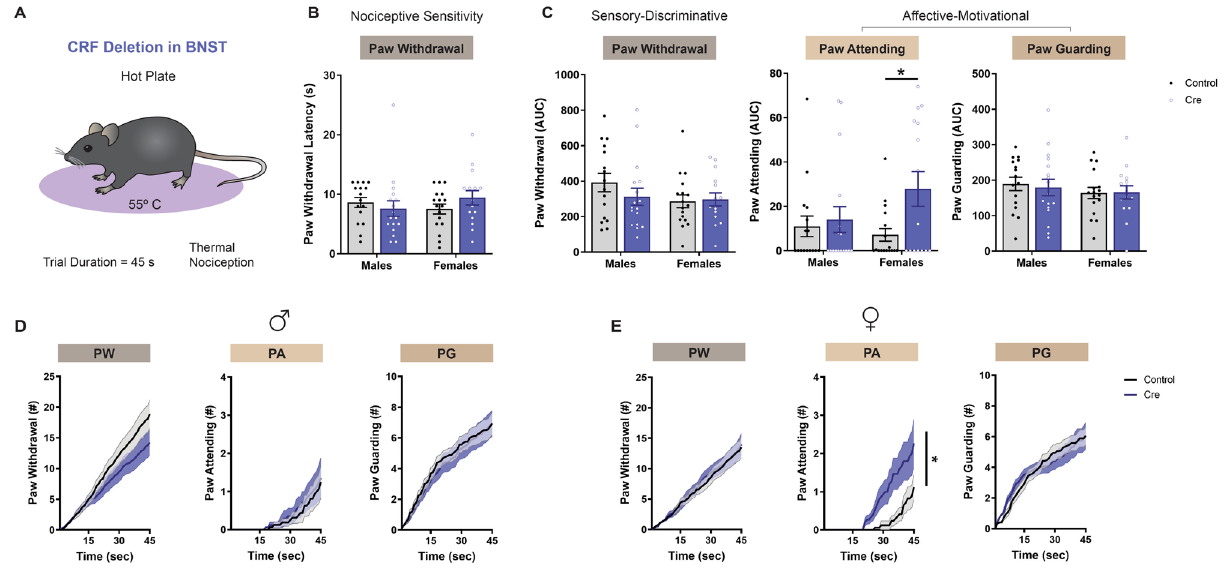
Figure 6. CRF Deletion in BNST Selectively Alters Sensory-Discriminative and Affective-Motivational Behaviors. ( A ) Schematic of hot plate test. ( B ) Thermal nociceptive sensitivity of male (n = 16–17) and female (n = 15–17) Floxed-CRF mice, as defined by latency to first paw withdrawal for each mouse (Two- way ANOVA with Tukey’s post hoc: no Sex × Virus interaction [F(1, 61) = 1.853, P = 0.1785] or main effect of Sex [F(1, 61) = 0.1124, P = 0.7386] and Virus [F(1, 61) = 0.1524, P = 0.6976]). ( C ) Quantification of sensory- discriminative and affective-motivational behaviors throughout the 45-s exposure to hot plate. Averaged area under the curve (AUC) of paw withdrawal (Two-way ANOVA with Tukey’s post hoc: no Sex × Virus interaction [F(1, 61) = 1.072, P = 0.3047] or main effect of Sex [F(1, 61) = 1.885, P = 0.1747] and Virus [F(1, 61) = 0.6208, P = 0.4338]), paw attending (Two-way ANOVA with Tukey’s post hoc: no Sex × Virus interaction [F(1, 61) = 2.605, P = 0.1117] or main effect of Sex [F(1, 61) = 0.8298, P = 0.3659]; main effect of Virus [F(1, 61) = 4.695, P = 0.0342]), and paw guarding (Two-way ANOVA with Tukey’s post hoc: no Sex × Virus interaction [F(1, 61) = 0.09333, P = 0.7610] or main effect of Sex [F(1, 61) = 1.026, P = 0.3152] and Virus [F(1, 61) =